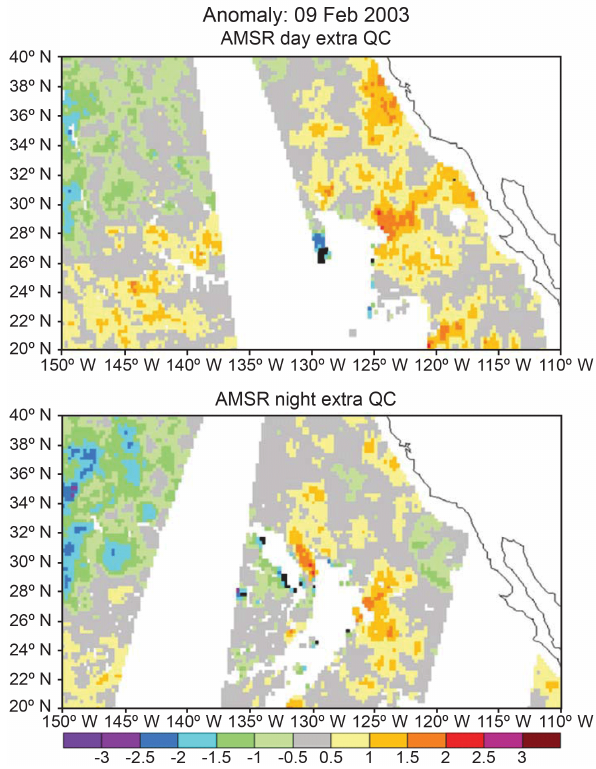
Figure A6. AMSR extra quality-controlled SST data anomalies for 9 February 2003. The black regions show where data have been rejected by the extra quality